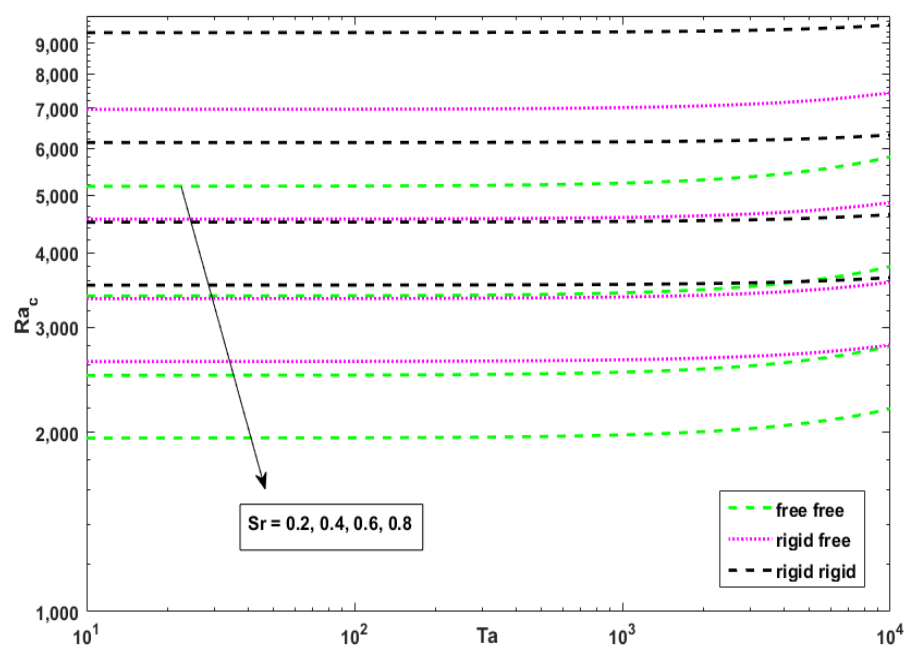
Figure 2. Variation of Ra c with Ta for Da = 0.01, Du = 0.02, Rs = 200, Le = 5, = 8, M = 0.9, ϕ = 0.9.